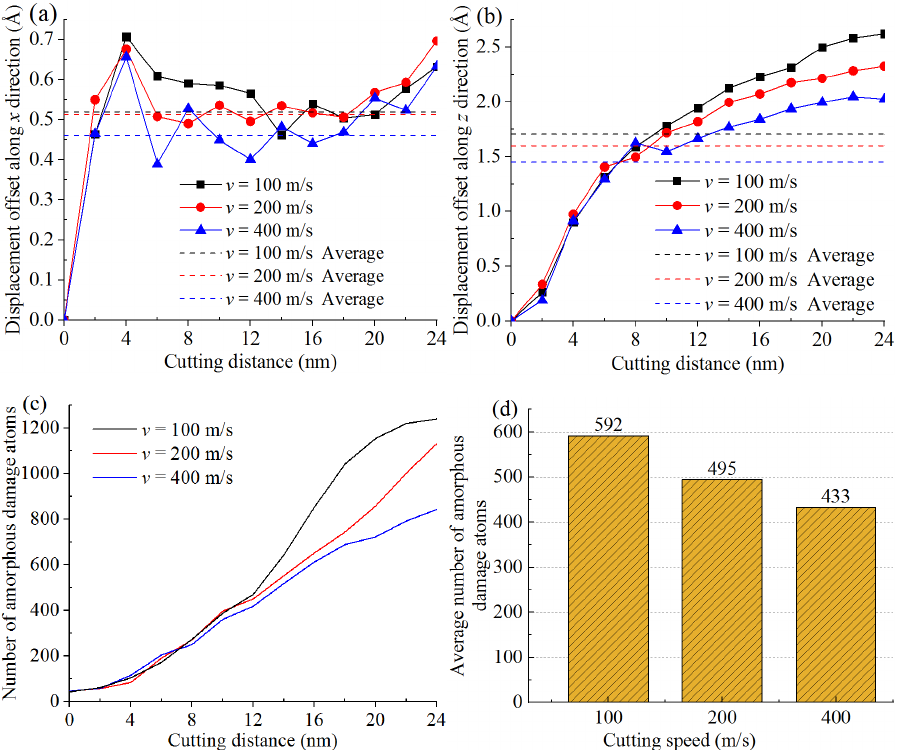
Figure 11. The analysis results of the tool wear at different cutting speed. Displacement offset along ( a ) x and ( b ) y direction; ( c ) Number of amorphous damage atoms; ( d ) Average number of amorphous damage atoms.